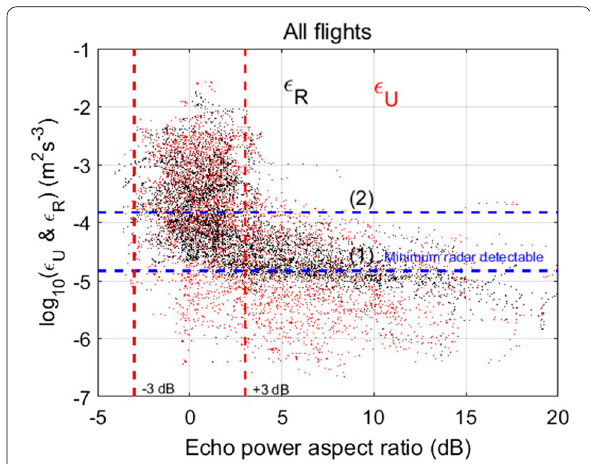
Fig. 10 Radar echo power aspect ratio (dB) defined as log10 ( P v ) − ( log10 ( P N ) + log10 ( P E ))/ 2 calculated in the same way as σ 2 (“Theoretical bases and practical methods of ε estimation” section) versus log10 (ε R ) (black dots) and log10 (ε U ) (red dots). The statistics was made on the ShUREX2016 flights. The blue dashed line (1) shows the minimum ε values detectable by the radar. The blue dotted dashed line shows the level equal to 10 times the minimum threshold